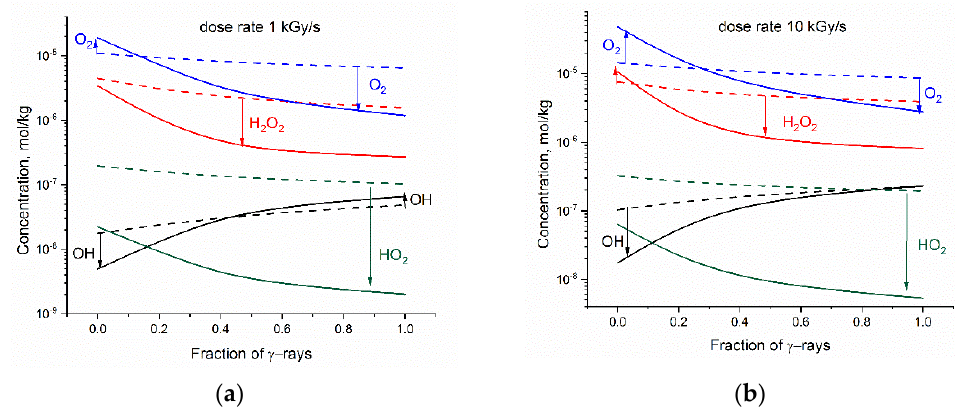
Figure 3. Simulated changes in the steady state concentrations of oxidants resulting from base addition vs. fraction of γ -rays in the mixed gamma - fast neutron radiation: ( a ) dose rate 1 kGy·s − 1 ; ( b ) dose rate 10 kGy·s − 1 . The solid and dashed lines refer to 2·10 − 4 mol kg − 1 LiOH aqueous solution and to neutral water, respectively. The direction of changes is marked by arrows.